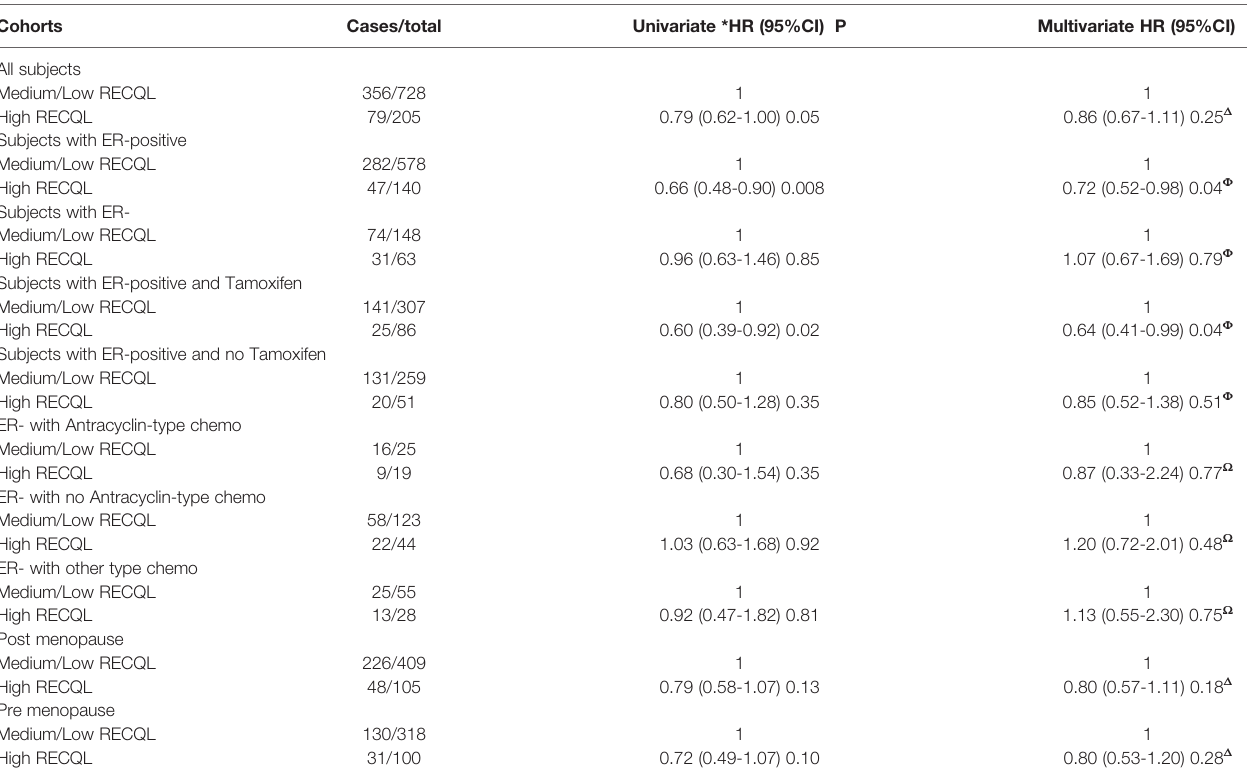
TABLE 2 | Comparison of 15-year survival between patients with high versus medium/low RECQL